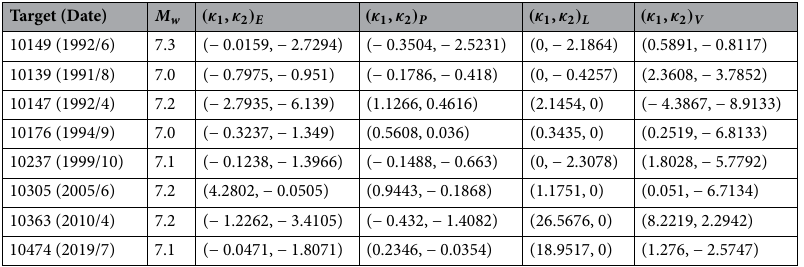
Table 1. Gauss curvature signatures of the eight large earthquakes, M w ≥ 7.0 (Subscripts E , P , L , and V correspond to the pseudo released energy, the pseudo power, the pseudo Laplacian’s first term, and the pseudo vorticity’s first term, respectively).